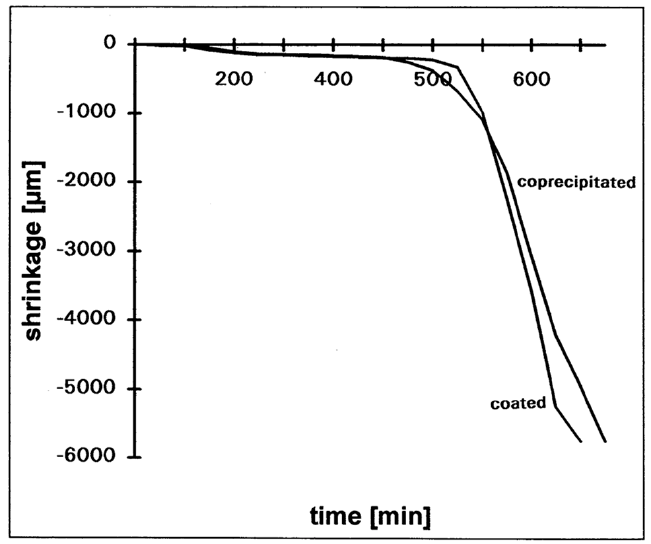
Figure 16. Shrinkage behaviour of different Y-TZP materials.